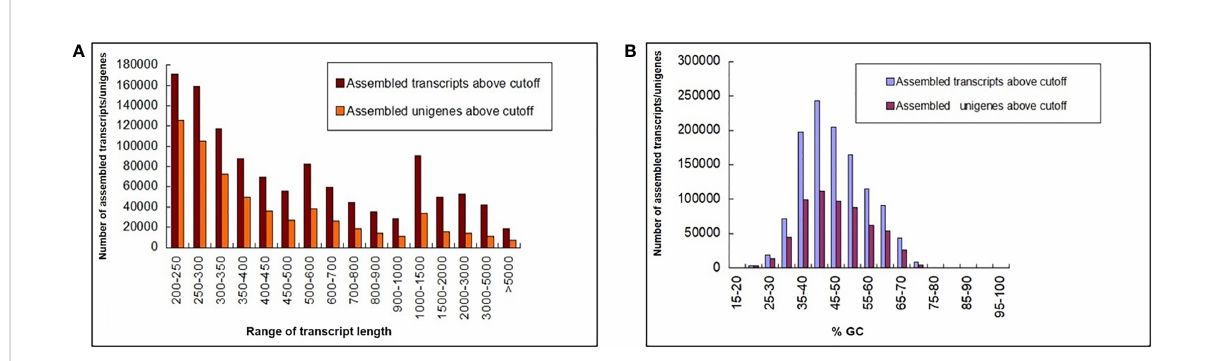
FIGURE 1 Length and GC content of the assembled transcripts/unigenes. (A) Bar chart depicting the length distribution and (B) GC summary of the assembled transcripts/unigenes. The y-axis represents the number of assembled transcripts/unigenes, the x-axis (left) represents the range of transcript length, and the x-axis (right) represents the